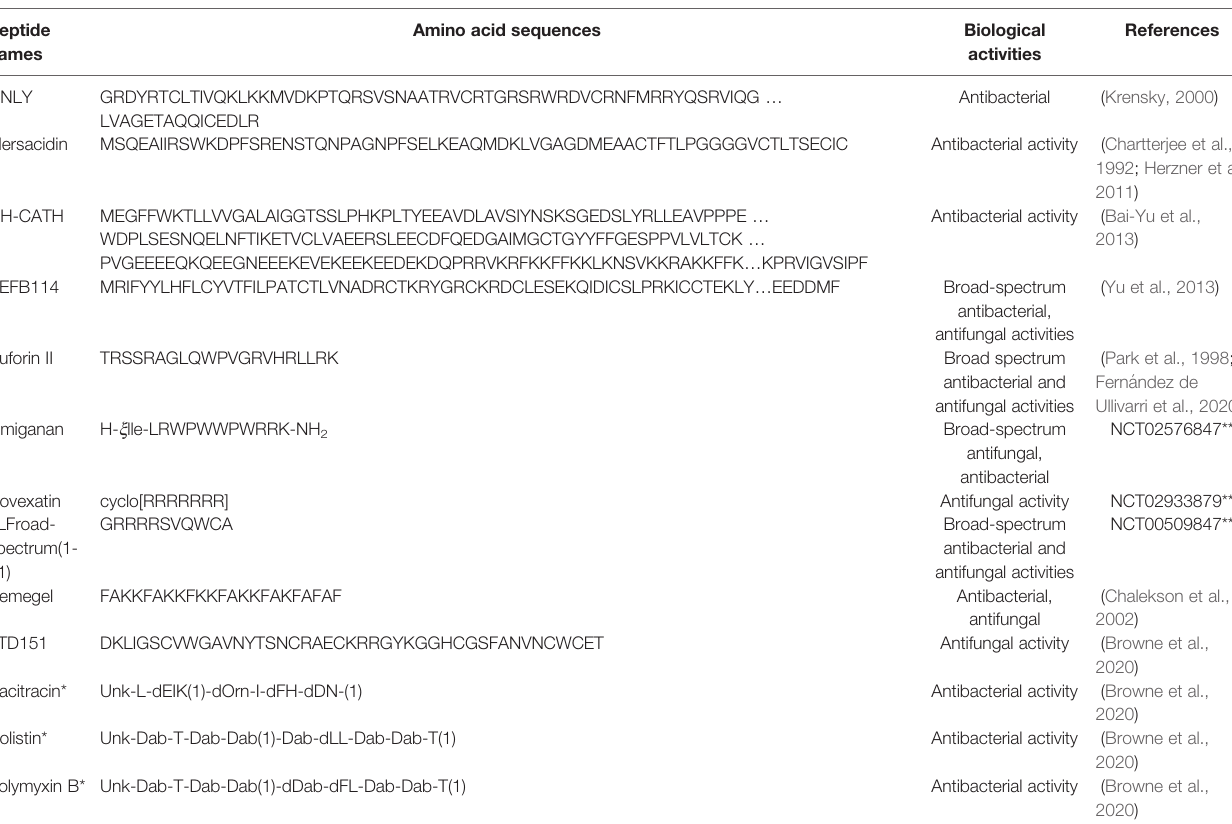
TABLE 3 | List of names, primary structure, biological activities, and references for the cited peptides with antimicrobial